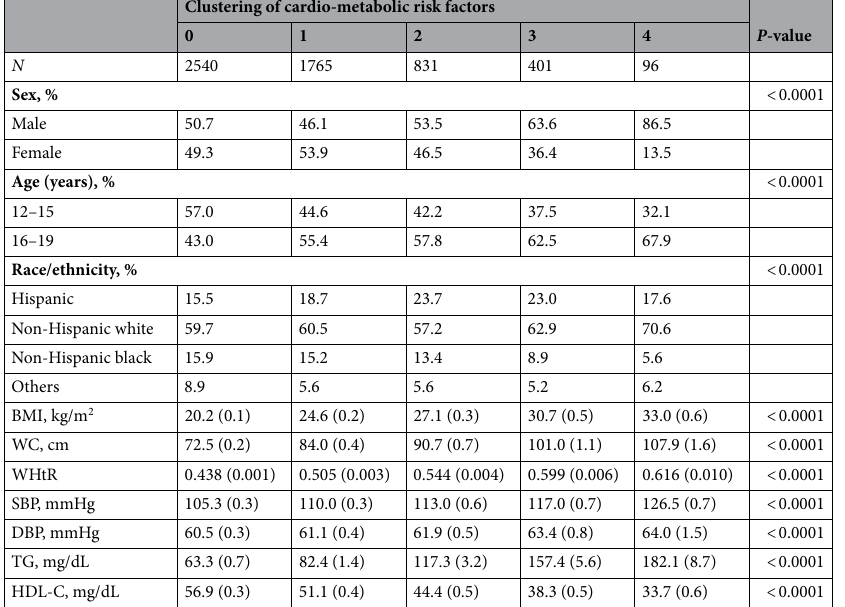
Table 1. Characteristics of U.S. adolescents aged 12–19 years, NHANES 1999–2014. Continuous variables are expressed as mean (SE).